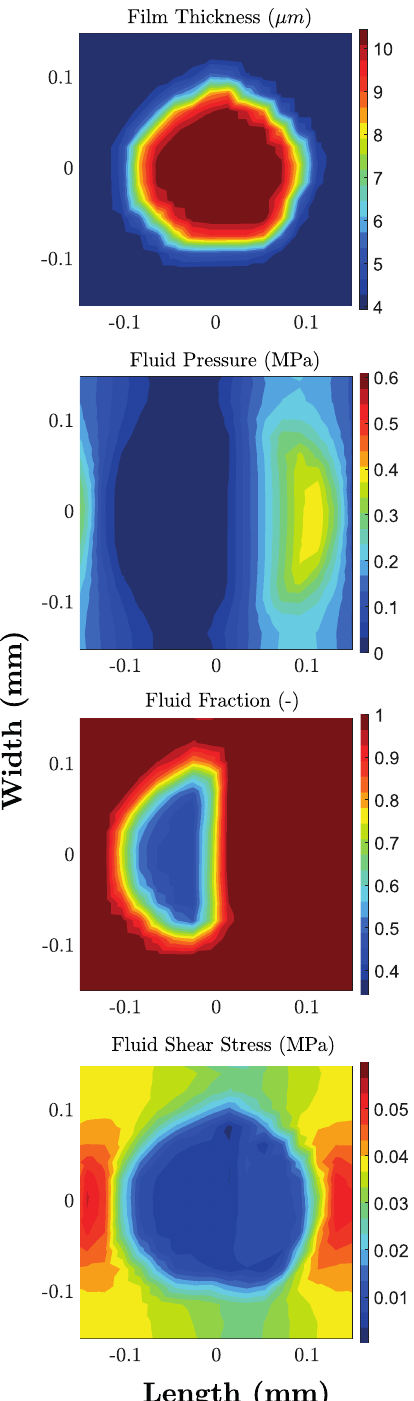
Figure 11. Contour plots for a single dimple, obtained from the uniform (44%) texture, for film thickness, fluid pressure, fluid fraction and average shear stress. Results, obtained by means of FV numerical simulations, refer to a Hersey number equal to η U / P av = 2.35 × 10 − 6